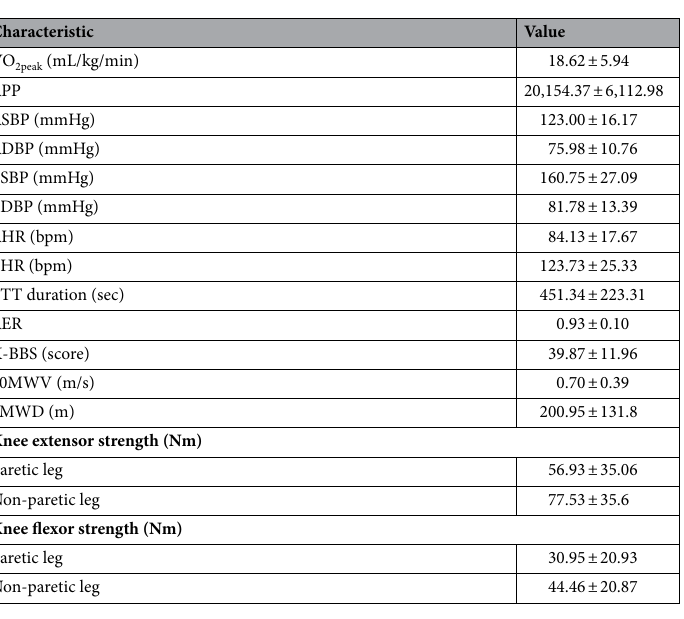
Table 2. The results of baseline evaluation of cardiovascular fitness, balance function, gait, and knee muscle strengths ( N = 83). Values represent mean ± standard deviation (SD). N: number, VO 2peak : peak oxygen